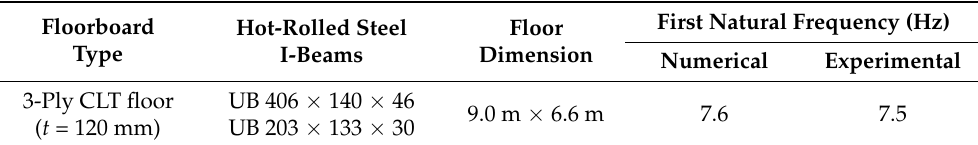
Table 6. The floor details and frequency results investigated by Huang et al. [44] (see Figure 6 for plan view of the floor).